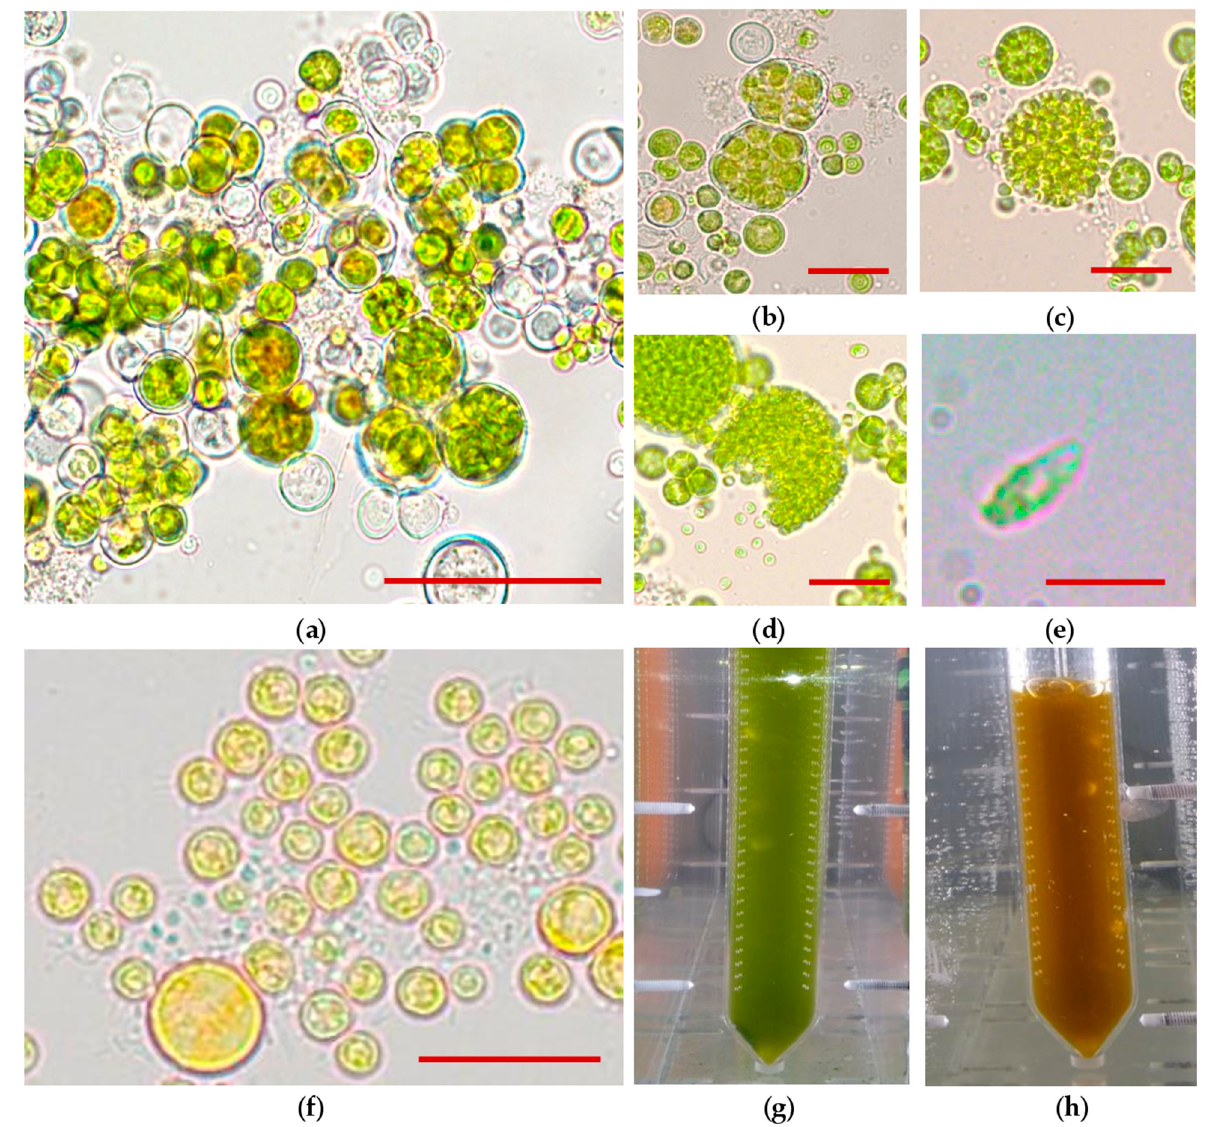
Figure 1. Studies of Bracteacoccus aggregatus BM5/15 (IPPAS C-2045) culture by light microscopy and its visual observation in bubble-column photobioreactors. ( a ) Aggregates of palmelloid cells at 2nd day of cultivation under the vegetative growth conditions, scale bar: 20 μ m; ( b ) autosporangium under the vegetative growth conditions (5th day), scale bar: 20 μ m; ( c ) zoosporangium under the vegetative growth conditions (5th day), scale bar: 20 μ m; ( d ) releasing of zoospores under the vegetative growth conditions (5th day), scale bar: 20 μ m; ( e ) biflagellate zoospore, scale bar: 4 μ m; ( f ) immotile palmelloid cells under the inductive growth conditions (3rd day), scale bar: 10 μ m; ( g ) cell suspension under the vegetative growth conditions; ( h ) cell suspension under the inductive conditions.